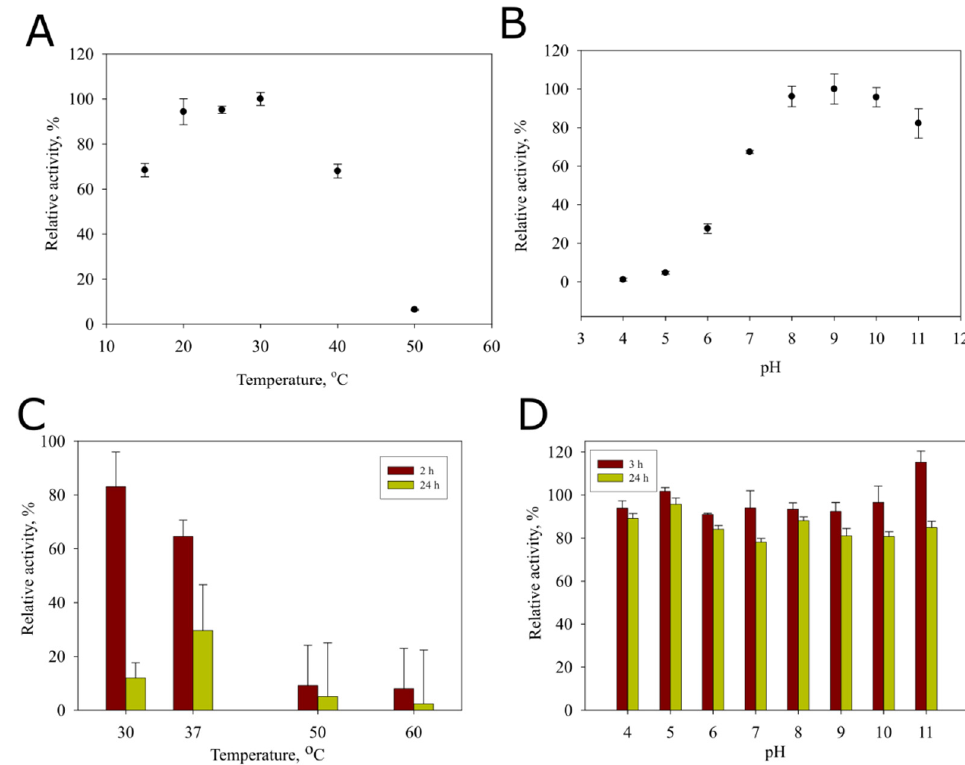
Figure 9. Effect of temperature and pH on activity and stability of 041 Δ 200YqfB. ( A , B )–activity of 041 Δ 200YqfB towards N 4 -acetyl-2 ′ -deoxycytidine at different temperatures and pH, respectively. ( C , D )–a residual activity of the enzyme incubated at different temperatures or pH for 2–24 h, respectively.